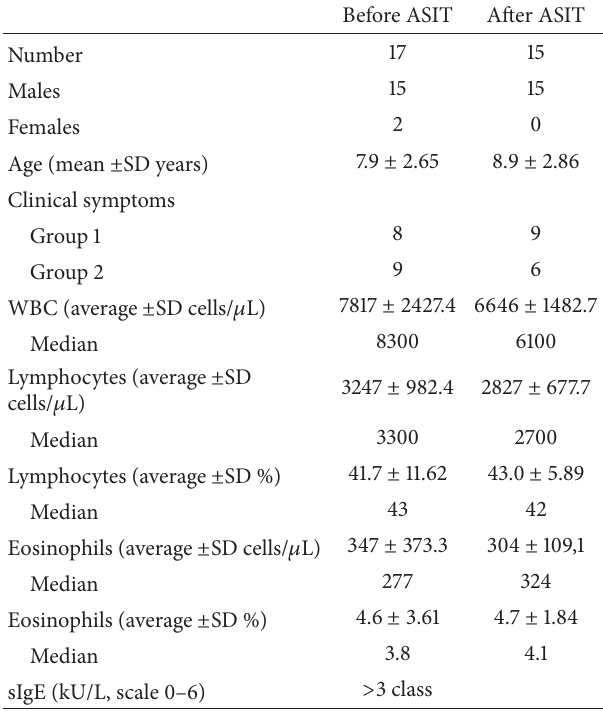
Table 1: Demographic and clinical characteristics of children with allergy before and one year after